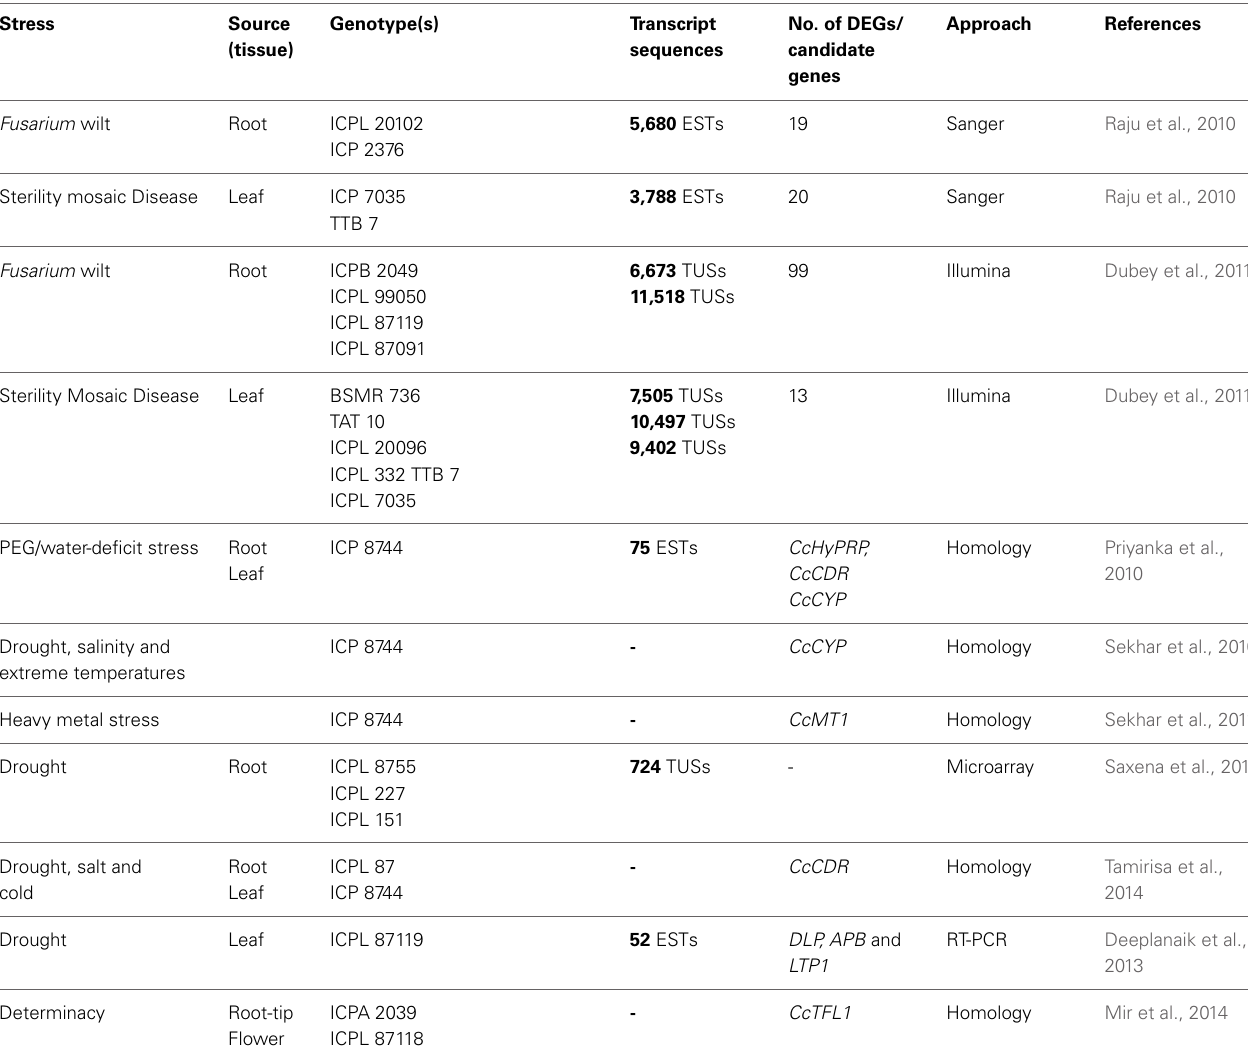
Table 4 | Select set of ESTs/candidate genes identified in